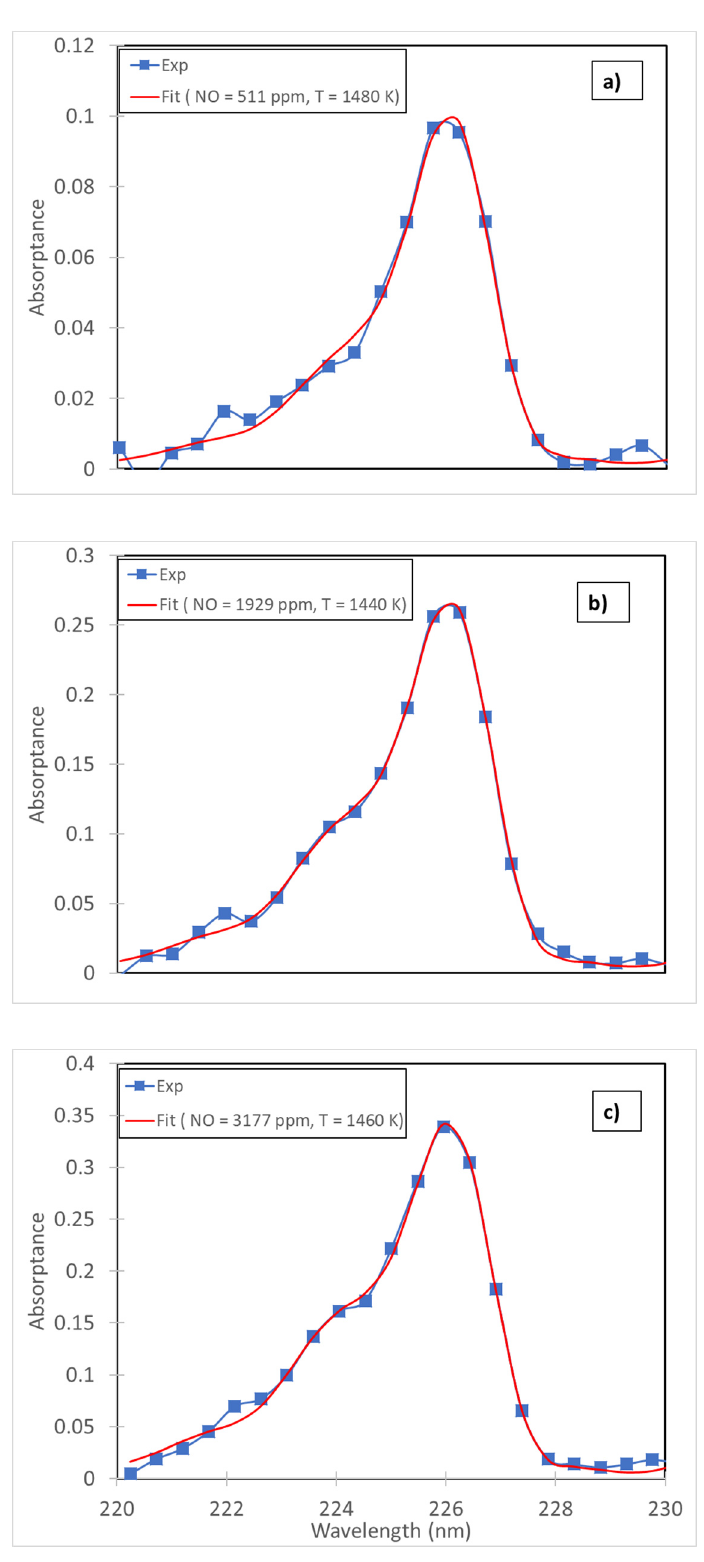
Figure 7. Measured and fitted NO spectra (L = 78 cm) in the ECF heated by H2-air combustion ( a ), N 2 Plasma ( b ) and Air Plasma ( c ) gases.